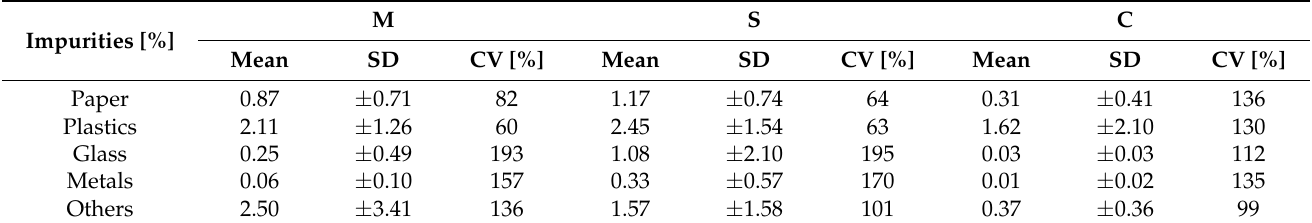
Table 3. Average share of impurities in SS-OFMSW from various sources (M, S, C).